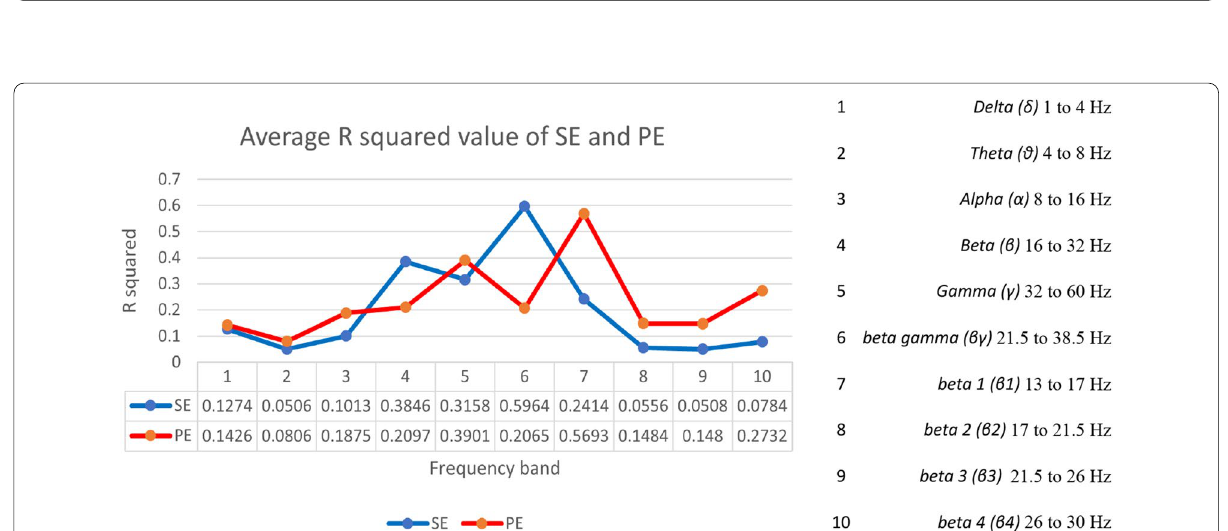
Fig. 3 The relationships of SE and PE with the BIS value: a SE, b PE. The best-fit line is red. The fitted linear relation indicates that the two methods are correlated (for Patient ID 10)